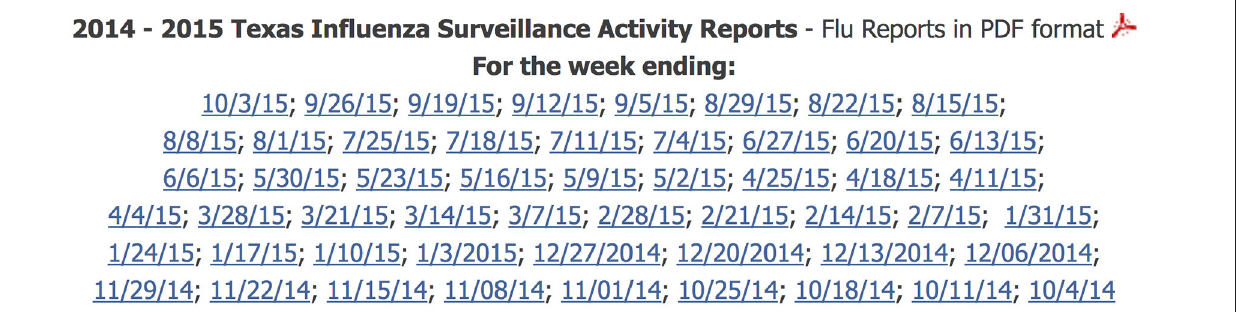
FIGURE 5 | Screenshot taken from Texas’ Department of State Health Services 2014–2015 weekly influenza reports web page (44). Texas identifies its weekly influenza surveillance PDF reports by trailing inclusive timestamps rather than by MMWR week (e.g., “10/3/15” instead of “2015, week 39”). Interestingly, much of the data in each PDF uses MMWR week numbers rather than timestamps.